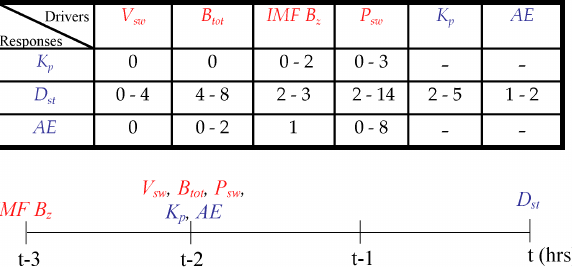
Fig. 5. Relative time shifts (h) between driver and response param- eters. D st actually responses to K p and AE (thus is sensitive to existing magnetospheric conditions), as well as to solar wind and